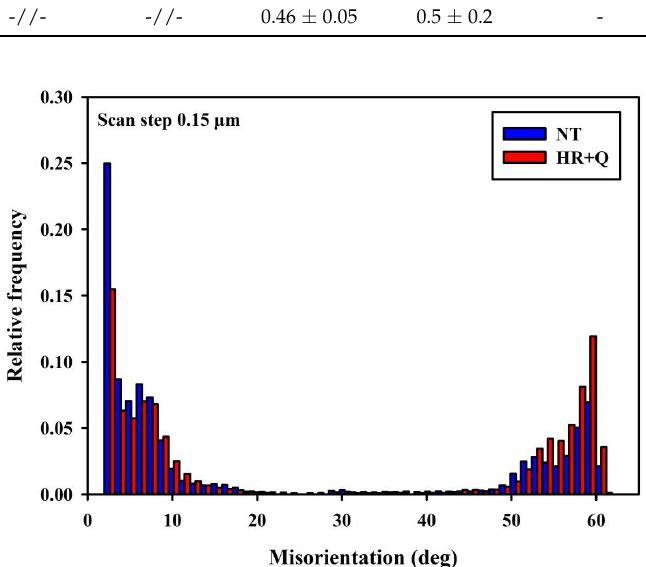
Figure 5. The distributions of grain boundary misorientations in the untempered NT and HR+Q samples.